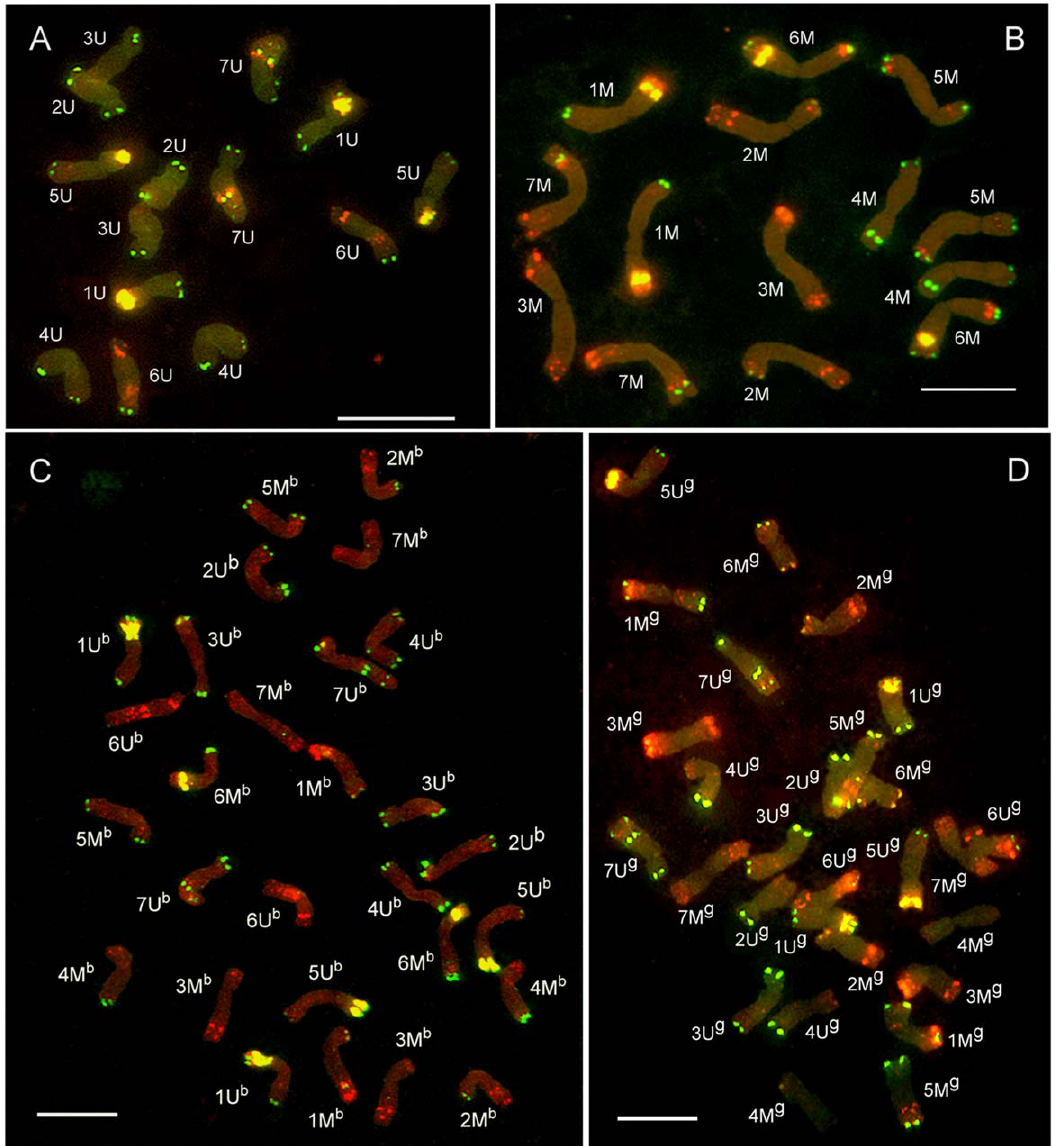
Figure 2. Distribution of DNA repeats on mitotic chromosomes. Fluorescence in situ hybridization (FISH) was done with probes for repetitive DNA: pSc119.2 (green), Afa family (red) and pTa71 (yellow) on mitotic metaphase spreads of Ae. umbellulata MvGB470 (A); Ae. comosa MvGB1039 (B); Ae. biuncialis MvGB382 (C); and Ae. geniculata AE1311/00 (D). Scale bars=10 m m.